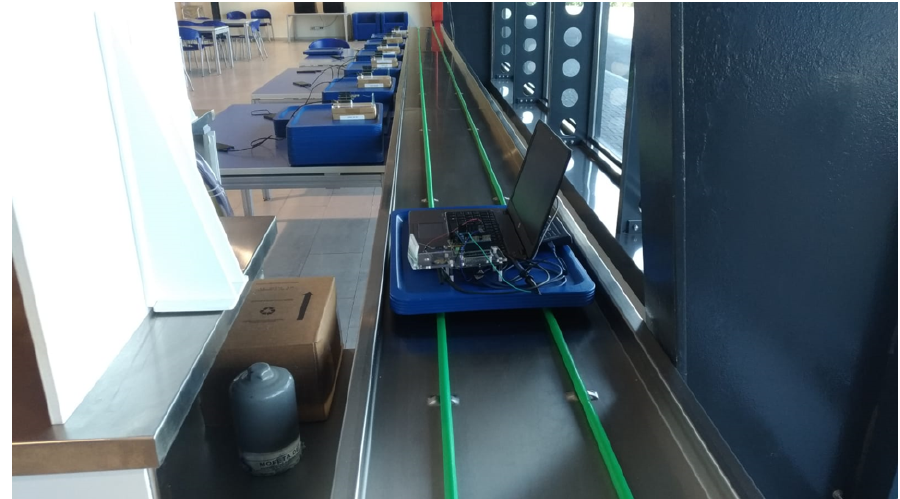
Figure 12. Experimental setup: placement of readers and the tag on the conveyor belt probed by the oscilloscope.